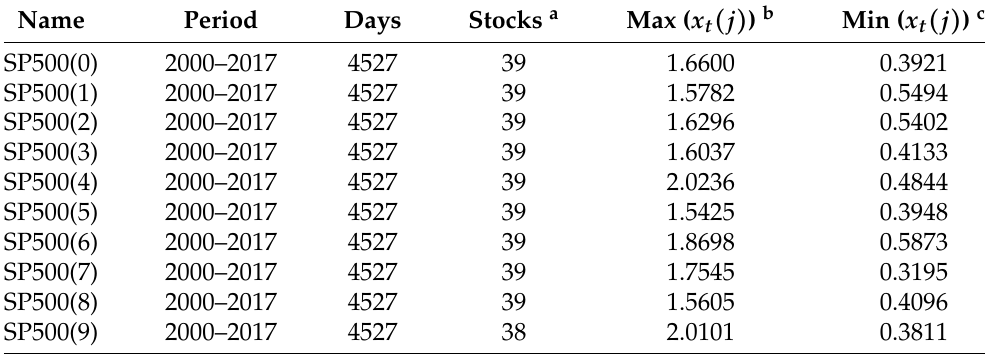
Table 1. Summary of the S&P 500